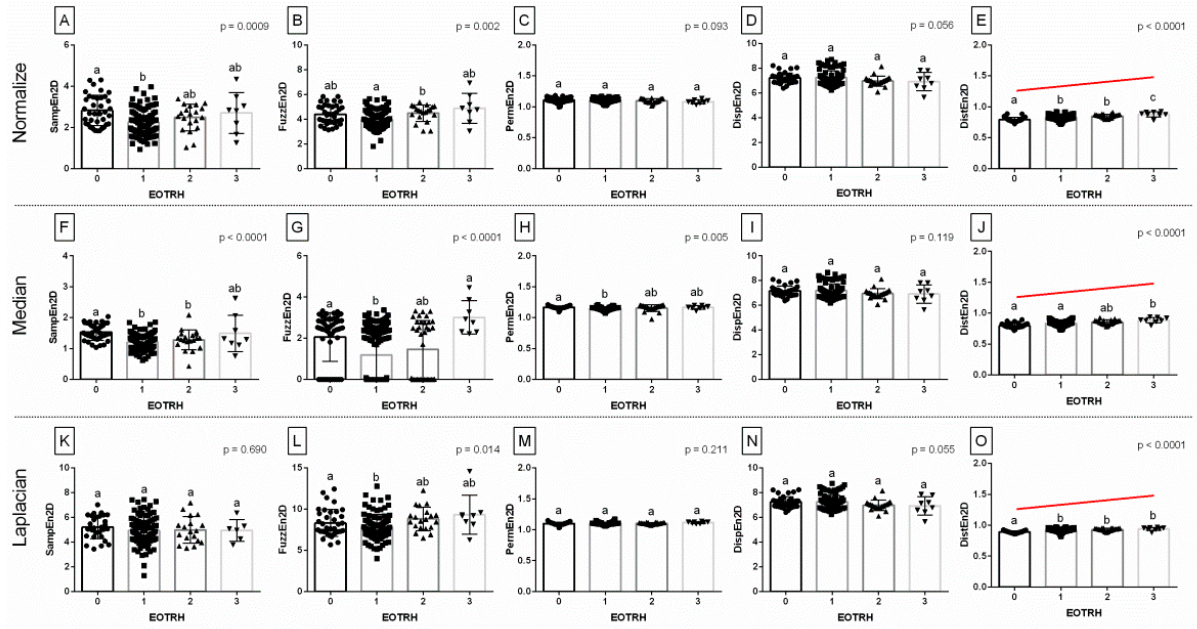
Figure 2. The comparison of the entropy measures between the EOTRH grades (0–3). The following entropy measures are considered: SampEn2D—two–dimensional sample entropy ( A , F , K ), FuzzEn2D—two–dimensional fuzzy entropy ( B , G , L ), PermEn2D—two–dimensional permutation entropy ( C , H , M ), DispEn2D—two–dimensional dispersion entropy ( D , I , N ), DistEn2D—two–dimensional distribution entropy ( E , J , O ). The output radiographs filtered by Normalize ( A – E ), Median ( F – J ), and Laplacian Sharpening ( K – O ) filtering algorithms are separated by dashed horizontal lines. Lower case letters (a–c) indicate differences between groups for p < 0.05 independently for each measure. The significant increase with the EOTRH grades is marked with a red line. Single realizations are marked with dots. Among the 18 returned combinations of selected GLCM features ( n = 6) and filtering algorithms ( n = 3), all combinations differed significantly between the EOTRH grades and significantly increased with the EOTRH grades (Figure 4). Although some EOTRH grade–related increases were found between EOTRH 0 and 1 groups (Difference Variance after Median filtering, p < 0.0001, Figure 4K), between EOTRH 2 and 3 groups (Cluster Prominence after Median filtering, p < 0.0001, Figure 4G and Laplacian Sharpening filtering, p < 0.0001, Figure 4M; Contrast after Laplacian Sharpening filtering, p = 0.010, Figure 4N; Difference Average after Median filtering, p = 0.004, Figure 4I and Laplacian Sharpening filtering, p = 0.029, Figure 4O; Difference Entropy after Laplacian Sharpening filtering, p = 0.006, Figure 4P; Difference Variance after Laplacian Sharpening filtering, p = 0.0009, Figure 4Q; Inverse Variance after Median filtering, p = 0.018, Figure 4L and Laplacian Sharpening filtering, p = 0.002, Figure 4R), and EOTRH 1 and 3 groups (Contrast after Median filtering, p = 0.0009, Figure 4H; Difference Entropy after Median filtering, p = 0.0002, Figure 4J), all GLCM features significantly increased with the EOTRH grades from EOTRH 0 to 3 after Normalize filtering ( p < 0.0001, Figure 4A–F). All examined GLCM features extracted from Normalize filtering output radiographs were the lowest in the EOTRH 0 group, higher in the EOTRH 1 and 2 groups, and the highest in the EOTRH 3 group, with no differences between the EOTRH 1 and 2 groups ( p < 0.0001, Figure 4A–F). This step extracted the GLCM features from the radiographs of equine incisor teeth, and selected those combinations of features and filters that changed with each EOTRH